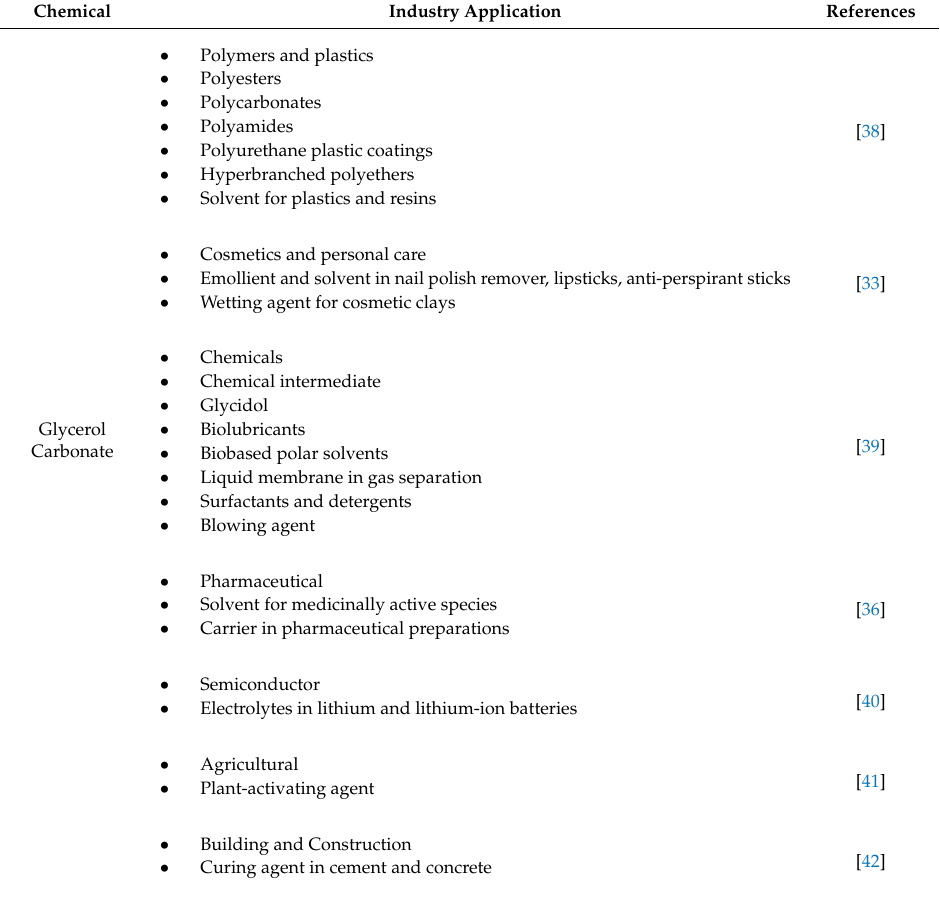
Table 3. The potential application of glycerol carbonate in various